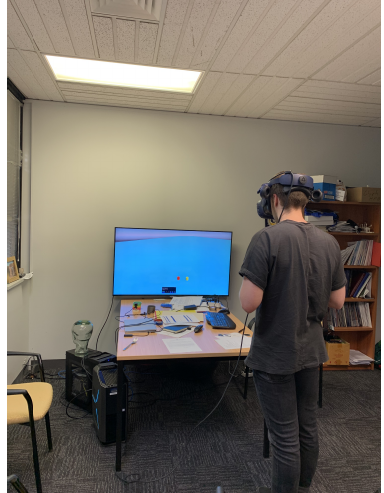
Figure 3. View of a participant during the